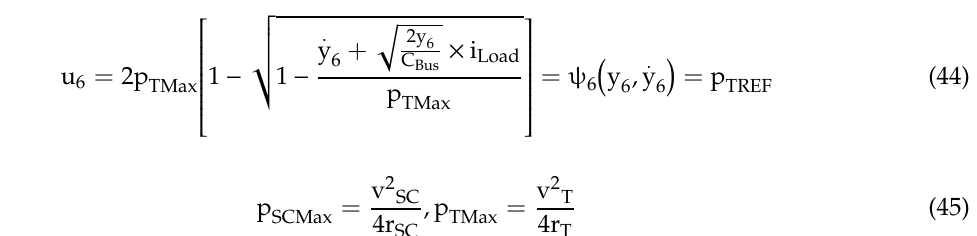
Figure 5. Proposed total energy stabilization.